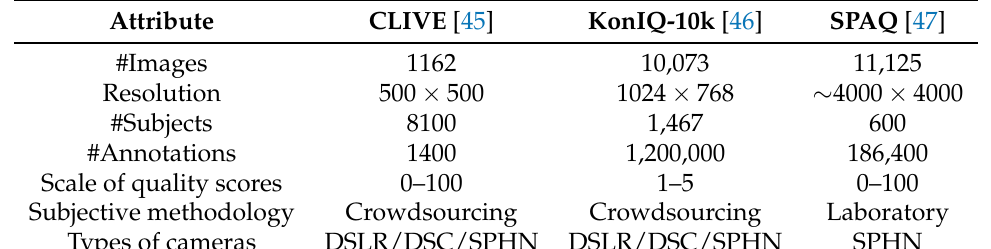
Table 1. Summary about the applied benchmark IQA databases with authentic distortions. DSLR: digital single-lens reflex camera. DSC: digital still camera. SPHN: smartphone.